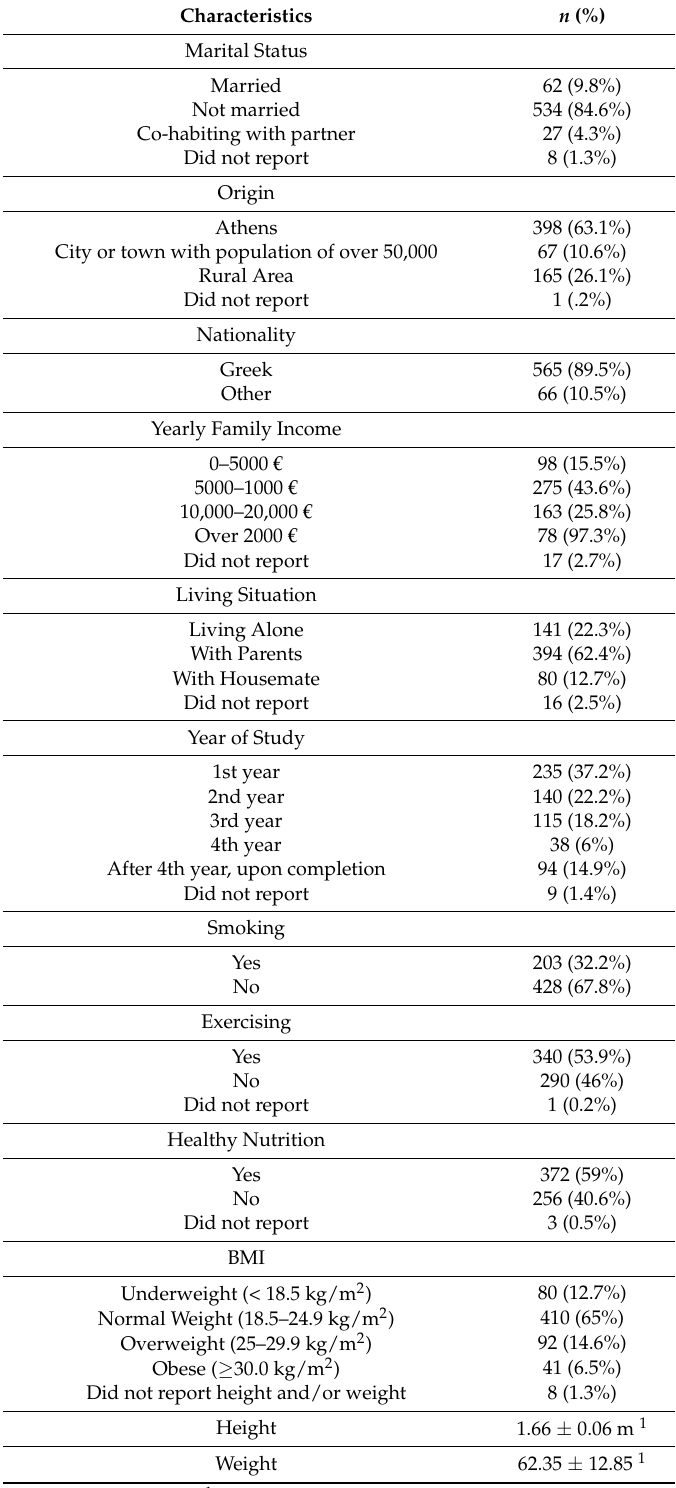
Table 1. Demographic and Clinical Characteristics of the